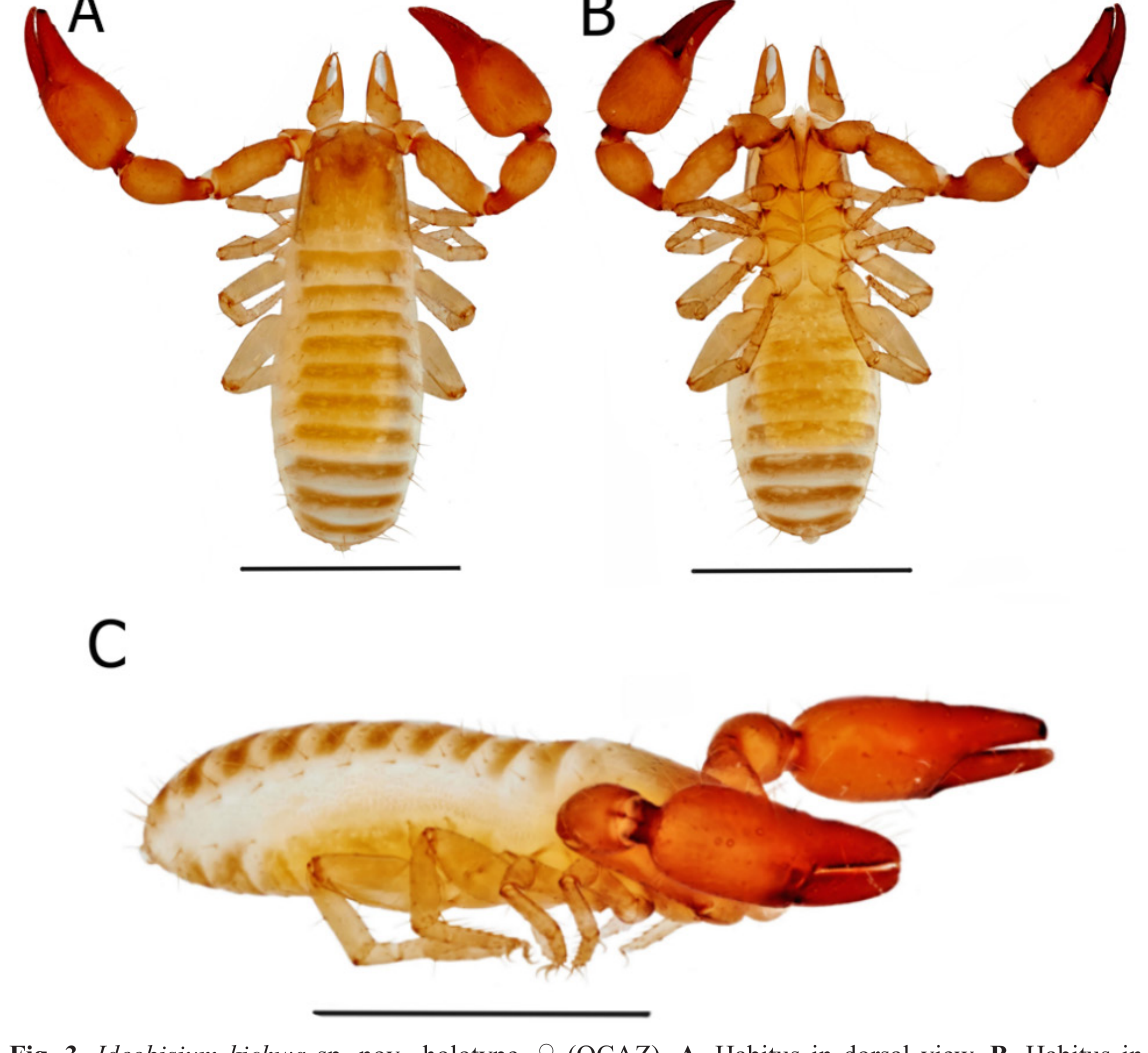
Fig. 3. Ideobisium kichwa sp. nov., holotype, ♀ (QCAZ). A . Habitus in dorsal view. B . Habitus in ventral view. C . Habitus in lateral view. Scale bars = 1